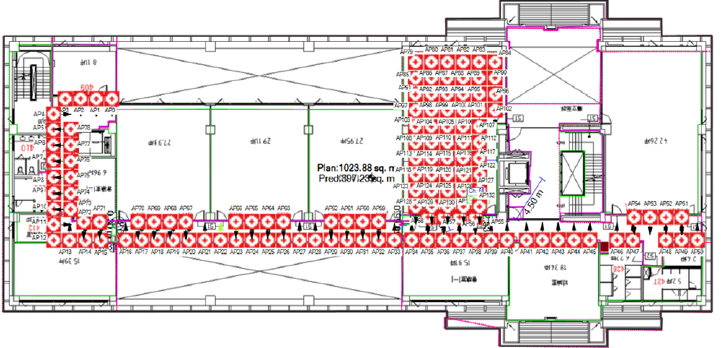
Figure 3. Wi-Fi Sniffers are deployed at R possible locations in the area of interest in the using simulation tool.